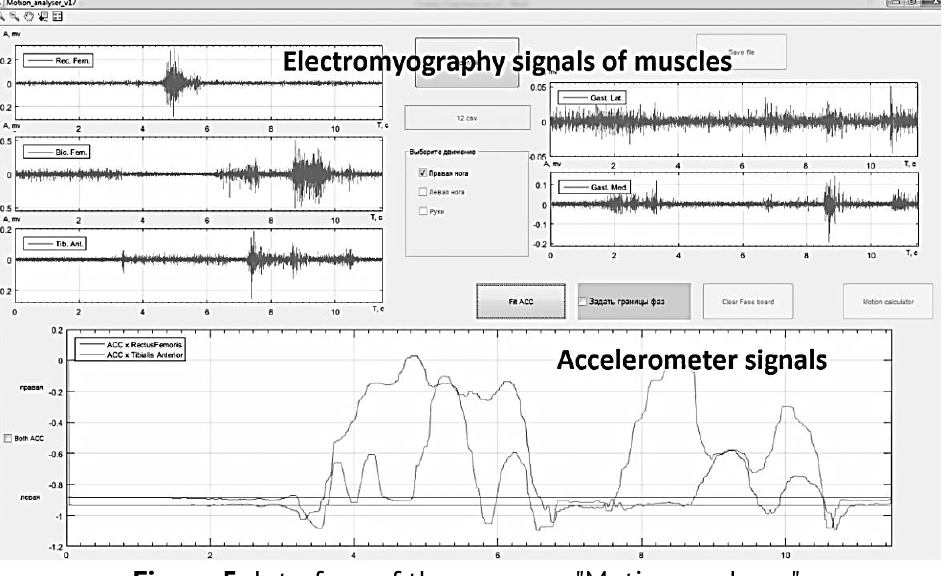
Figure 5. Interface of the program "Motion